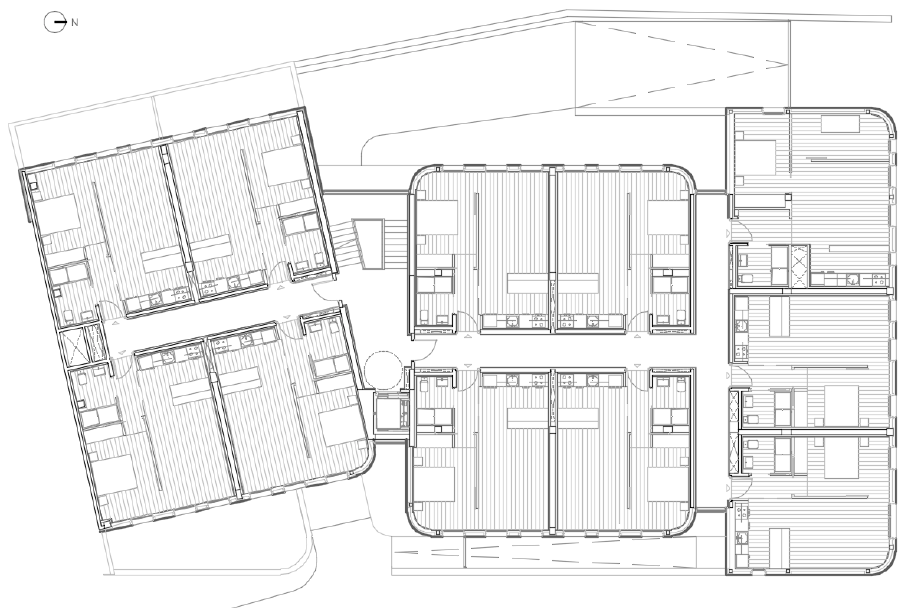
Figure 3. General floor plan of the project for 43 housing units in Irun-Larzabal, by the architect Asier Acuriola.